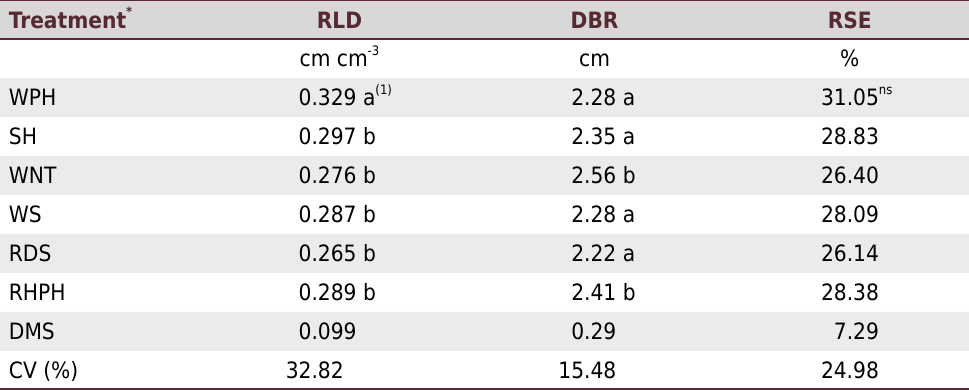
Table 3. Root length density (RLD), average distance between roots (DBR), and root soil exploration (RSE) after harvest in an area of sugarcane crop renewal under different tillage operations, in